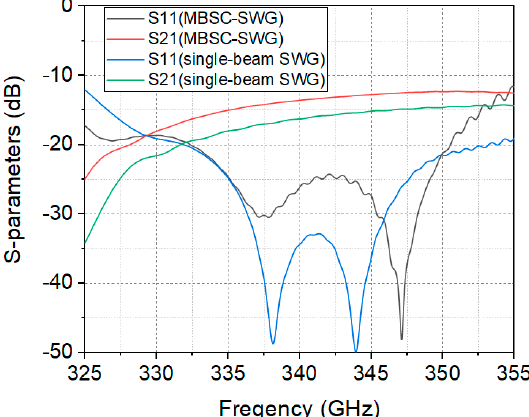
Figure 9. Simulation results of S-parameters for MBSC-SWG-SWS and single-beam SWG SWS.